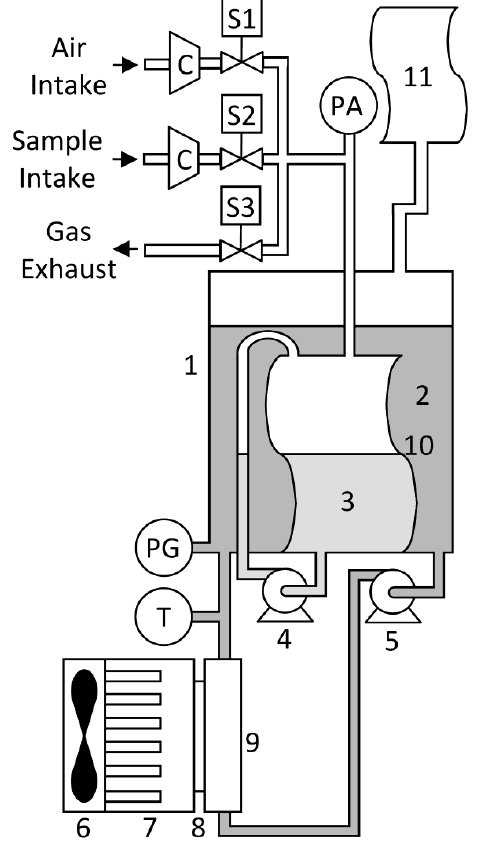
Figure 2. Schematic of the carbon dioxide-methane gas sensor. 1—container; 2—heat transfer fluid; 3—absorption liquid; 4 and 5—recirculation pump; 6—fan; 7—heat sink; 8—thermoelectric cell; 9—heat exchanger; 10—measurement cell; 11—flexible PVC reservoir; S1, S2 and S3—2-way solenoid valve; C—mini-compressor; PA—absolute pressure sensor; PG—gauge pressure sensor; T—temperature